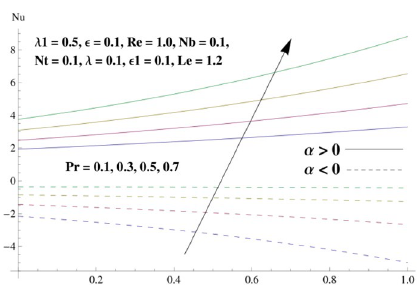
Figure 17. Behavior of Nu against Pr and γ .